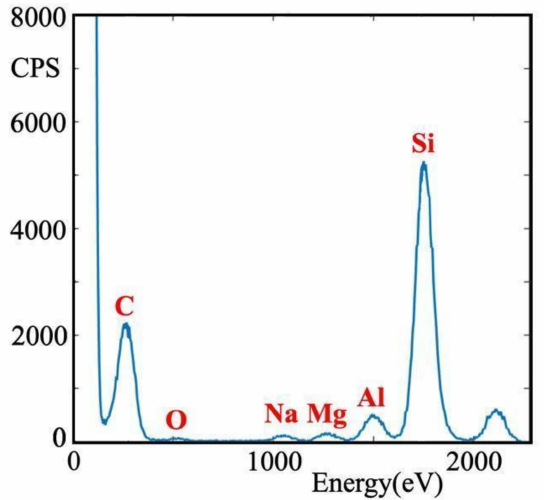
Figure 4. XRF measurement of a graphite sheet with an excitation energy of 2100 eV performed at the DXR1 beamline (CPS =